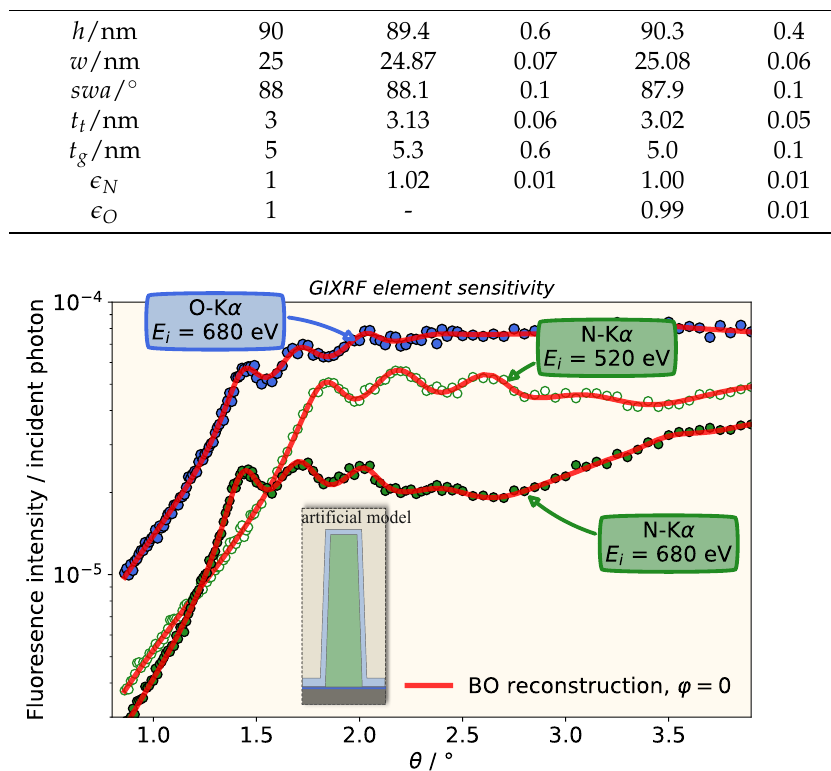
Figure 3. Comparison of the expected artificial disturbed simulated N-K α (green points) or O-K α (blue points) fluorescence intensities for the different excitation energies and the corresponding BO reconstruction. Clearly visible is how the first peak in the nitrogen signal shifts with increasing energy to smaller incident